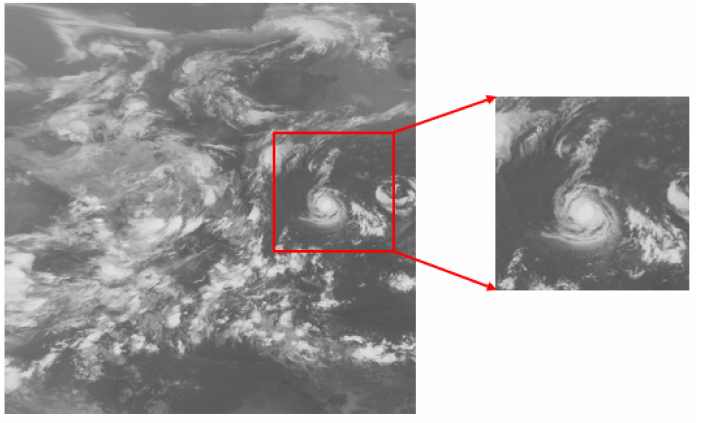
Figure 1. The original satellite cloud image and cut-out image of the strong typhoon Jelawat from JMBSC.